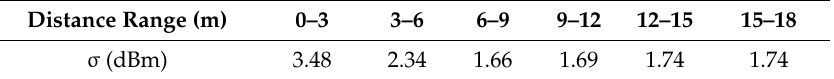
Table 2. Variance of RSSIs at di ff erent distances.